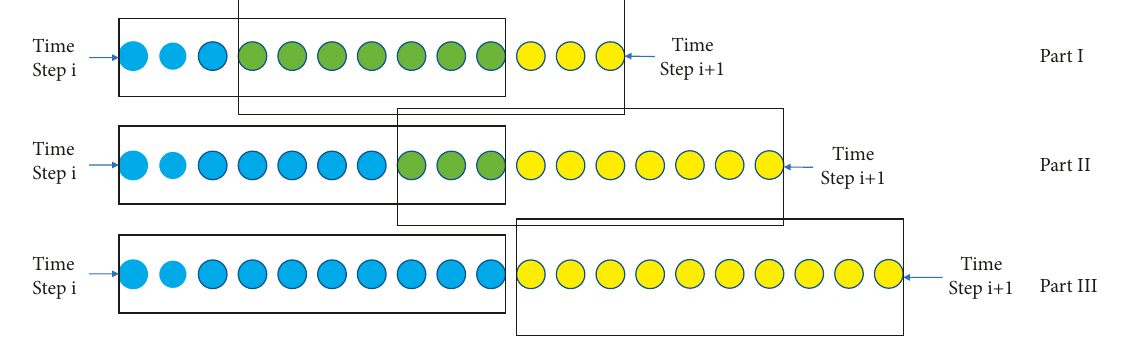
Figure 6: The details of the training process (taking one-dimension inputs as an example).